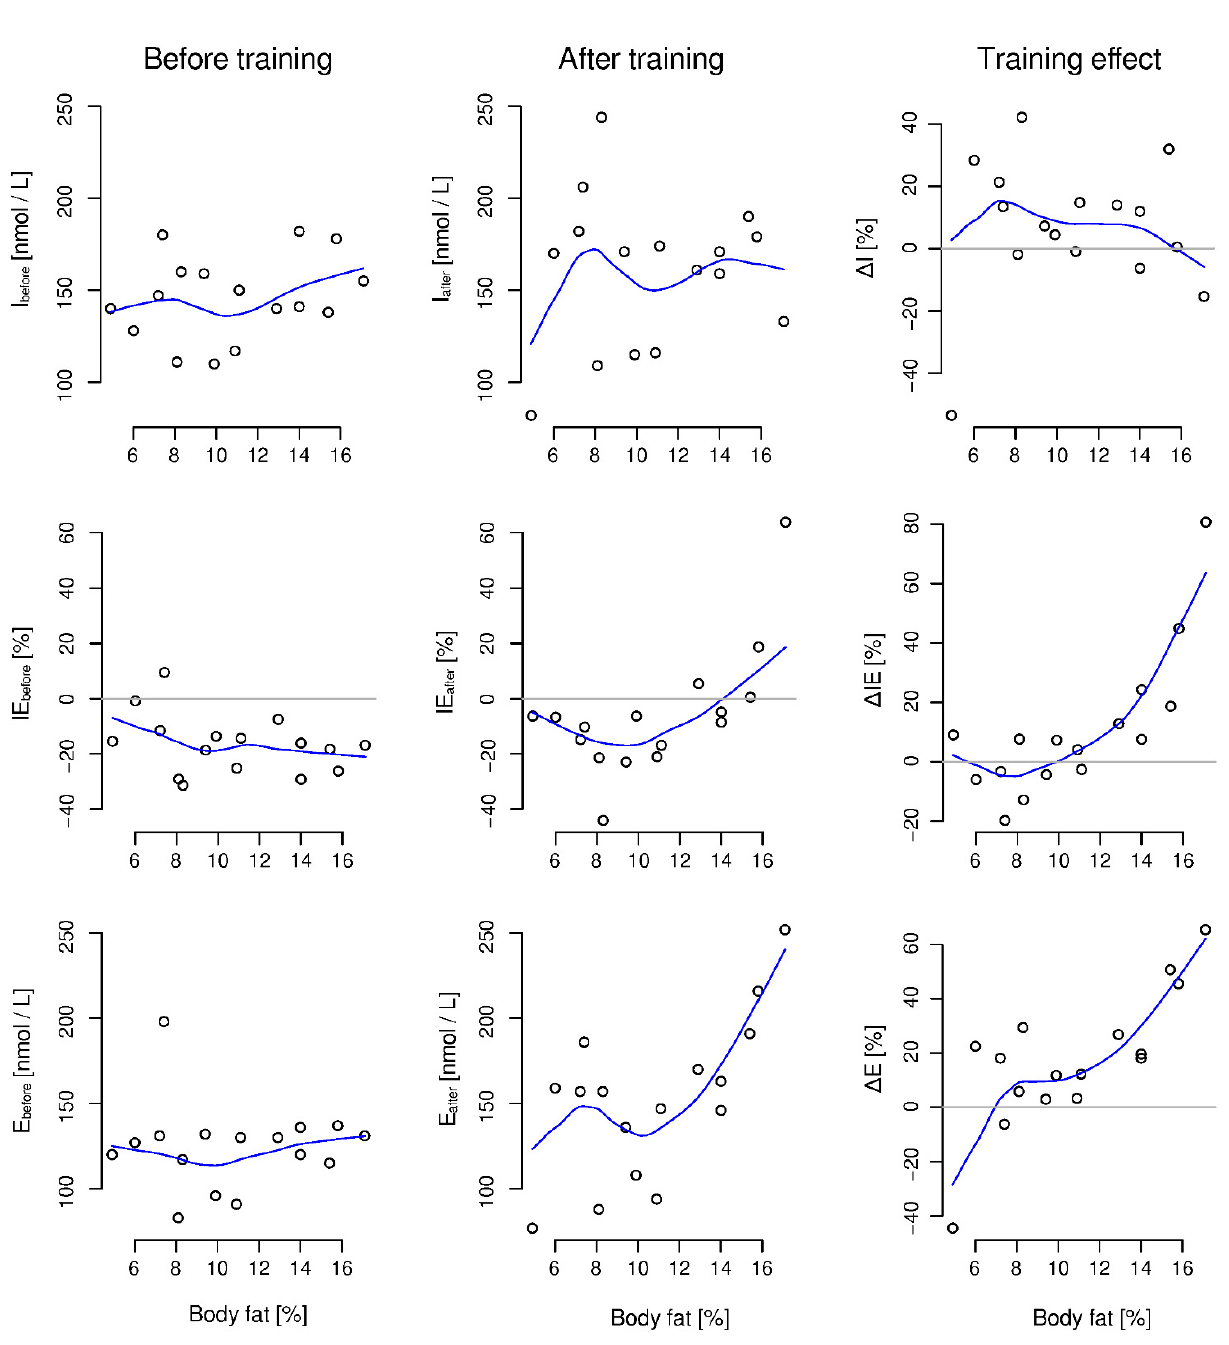
Figure 2. Relationships between body fat percentage and cortisol concentrations before and just after the exertion test, along with their changes due to the test and the training. Participants with a higher body fat percentage showed a more pronounced training effect in terms of a flattening of the immediate post-exertional drop in cortisol concentration ( Δ IE) and a much weaker, faintly evident increase in morning values ( Δ I). Thus, a higher percentage of body fat was associated with a more pronounced overall training effect in terms of the increase in post-exertional cortisol concentration ( ∆